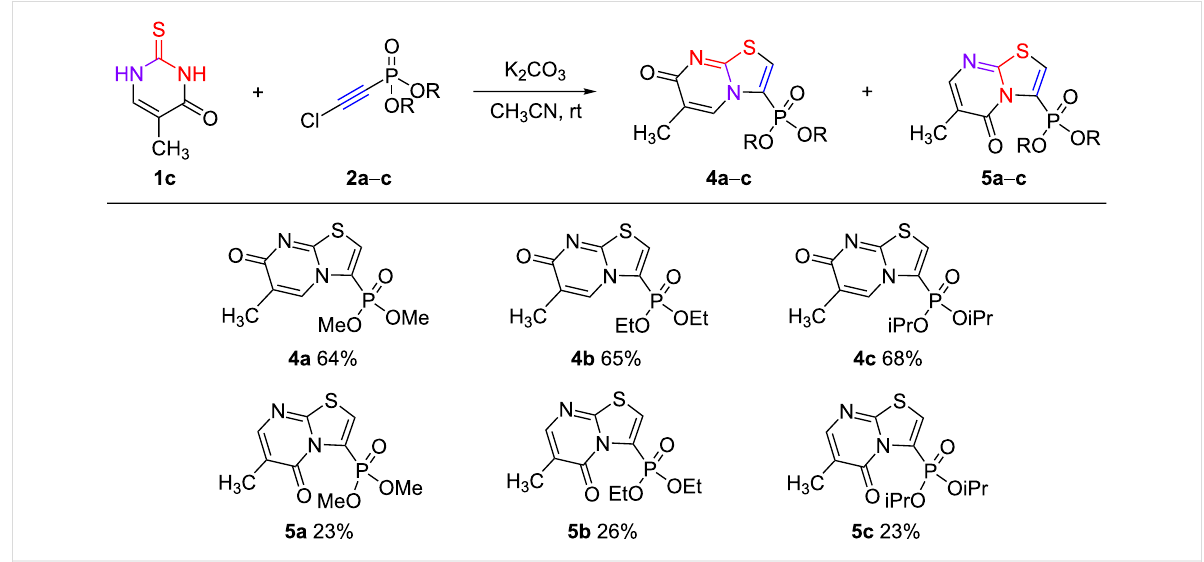
Scheme 7: Reaction of 5-methyl-2-thiouracil ( 1c ) with chloroethynylphosphonates 2a – c